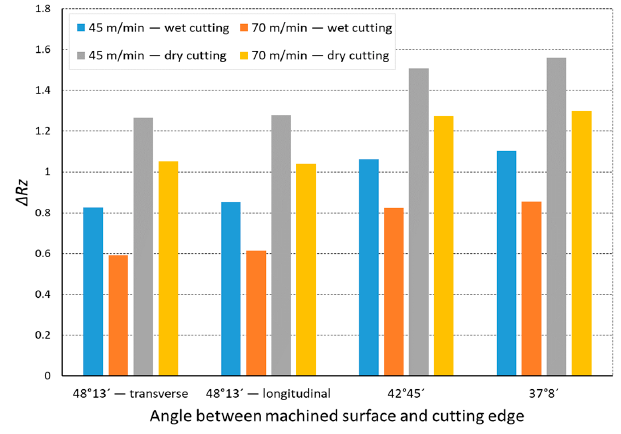
Figure 12. The impact of angle between the machined surface and cutting edge on ratio ∆ Rz of the average measured surface roughness height to the theoretical surface roughness Rz to for a rectilinear track and 23 HRC.